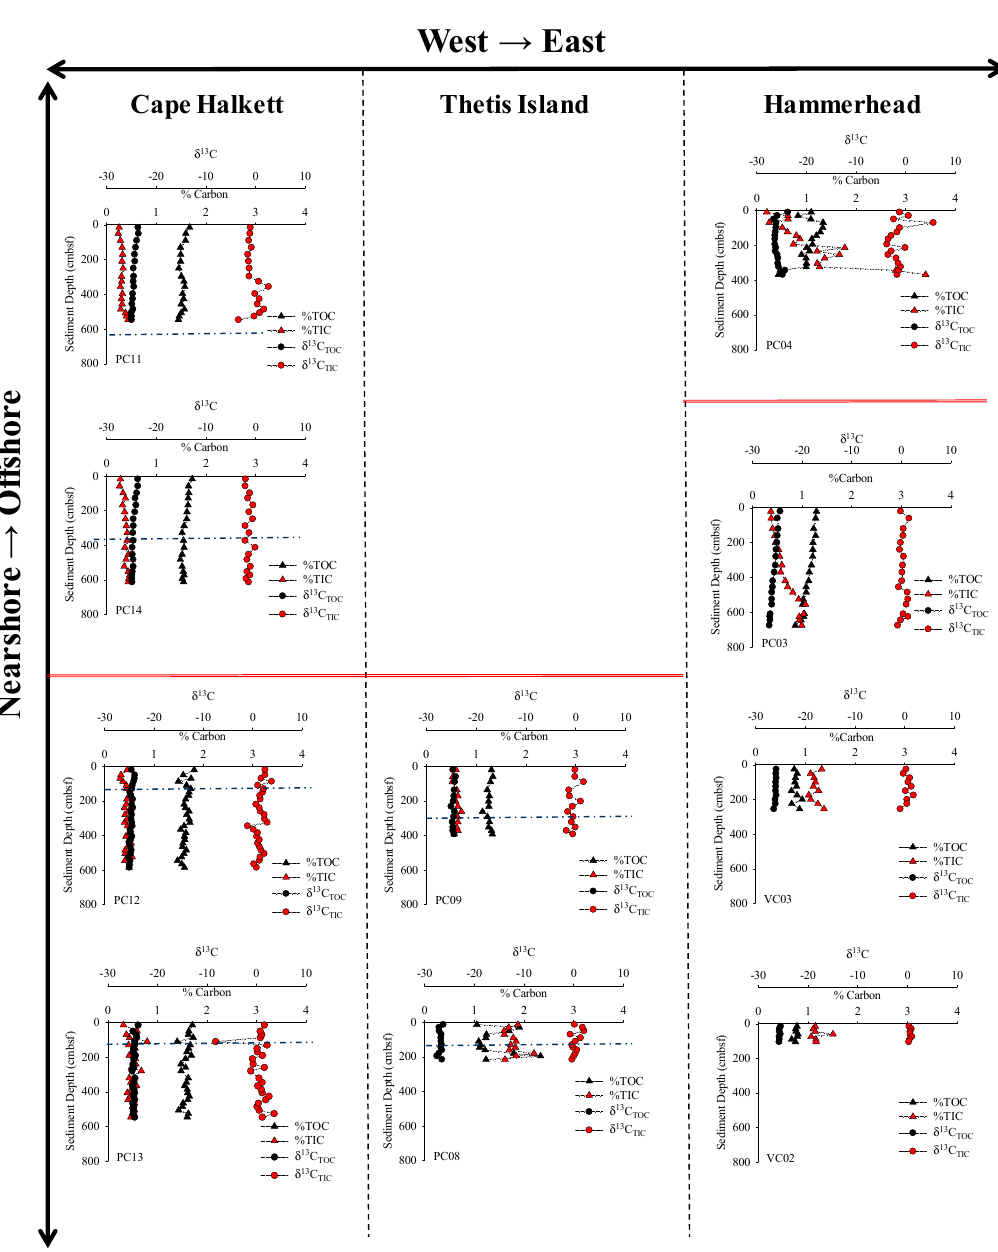
Figure 3. Sediment organic carbon (%TOC) and inorganic carbon (%TIC), expressed as % dry weight, and the δ 13 C ratio of each fraction, δ 13 C TOC and δ 13 C TIC , respectively, plotted vs. depth (cm) in the sediment below seafloor (cmbsf) for cores collected along the North Slope of Alaska on the Beaufort Sea. Core profiles are separated into three distinct sampling transects (Cape Halkett, Thetis Island and Hammerhead) and displayed by relative location west-to-east (left-to-right) and offshore-to-nearshore (top-to-bottom) on the North Slope. The blue dashed line presented in plots with a measured SMT represents the depth reported in Table 1. The red line in each transect indicates the relative location of the shelf-break for each coring transect (Figure 1).